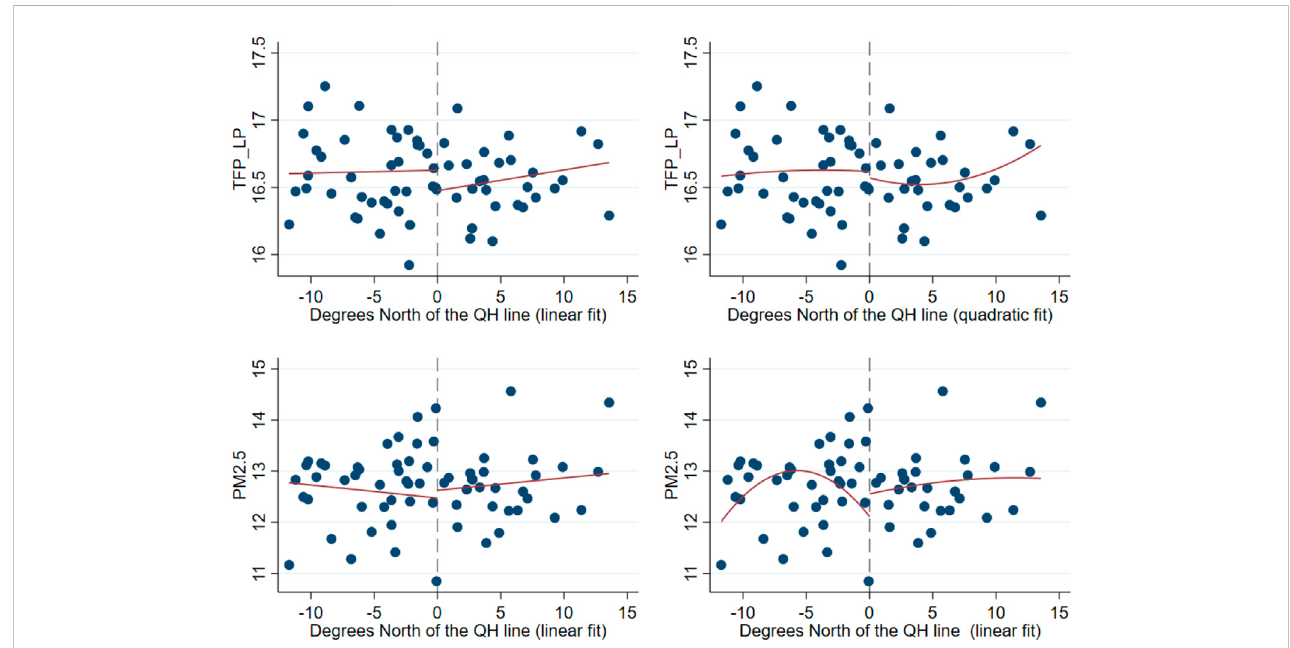
FIGURE 1 Discontinuity diagram of enterprise productivity and PM2.5 at the Qinling-Huai River boundary. Source: Compiled from regression results.